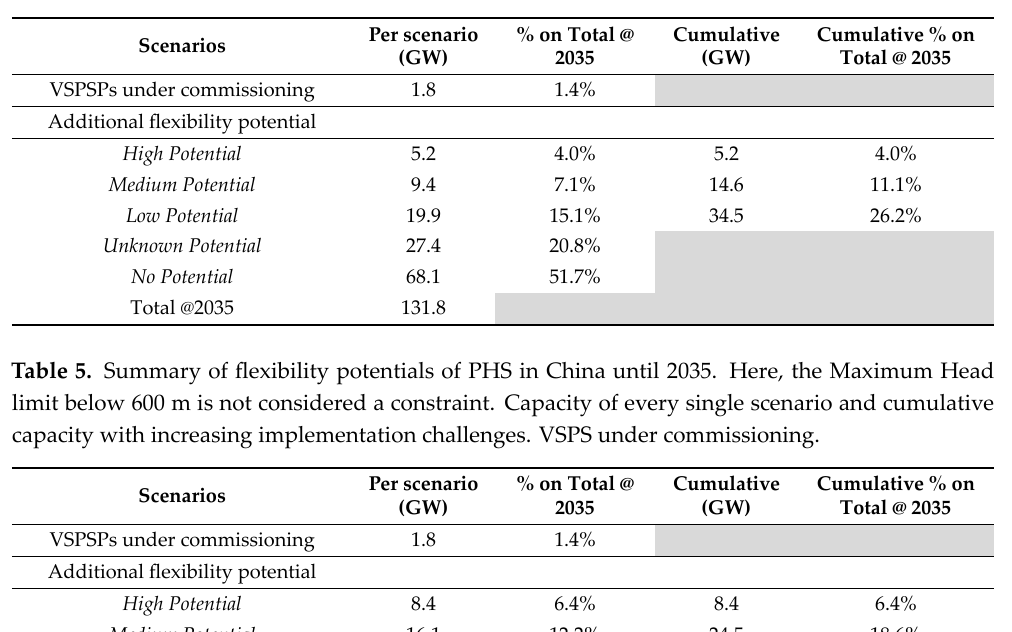
Table 4. Summary of additional flexibility potentials of PHS in China until 2035. Capacity of every single scenario and cumulative capacity with increasing implementation challenges. VSPS under commissioning (Fengning PSP) is included for reference.